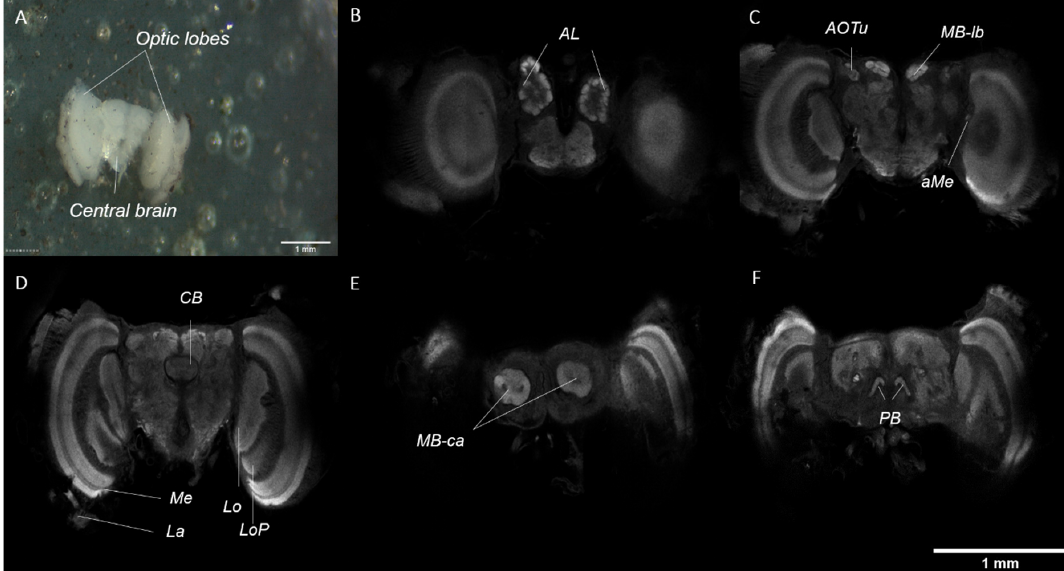
Figure 7. ( A ) Adult brain after dissection, showing the two optic lobes and the central brain ( B – F ). Visualisation of the adult brain, immunostained with an antibody against synapsin, in different confocal sections from most anterior ( B ) to most posterior ( F ). ( B ) Antennal lobes (AL). ( C ) Accessory medulla (aMe), anterior optic tubercles (AOTu), and mushroom body lobes (MB-lb). ( D ) Lamina (La), medulla (Me), the lobula (Lo), lobula plate (LoP), and the central body (CB). ( E ) Mushroom body calyx (MB-ca). ( F ) Protocerebral bridge (PB).